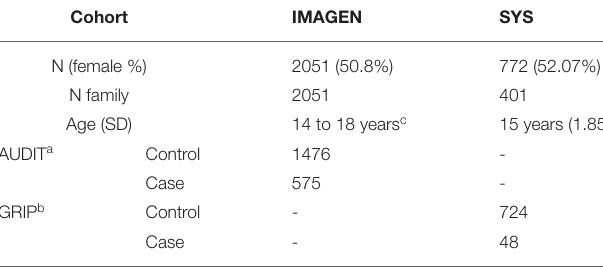
TABLE 1 | Description of subjects in IMAGEN and